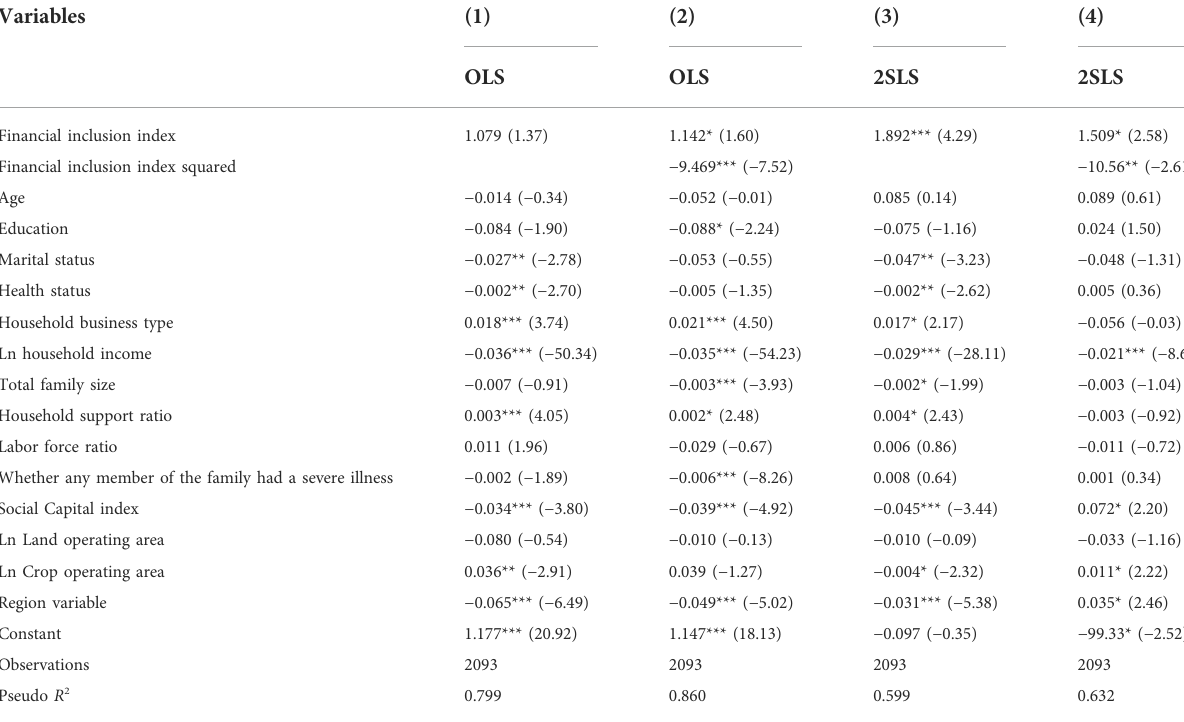
TABLE 3 Model fi tting results of fi nancial inclusion on economic vulnerability of rural households.